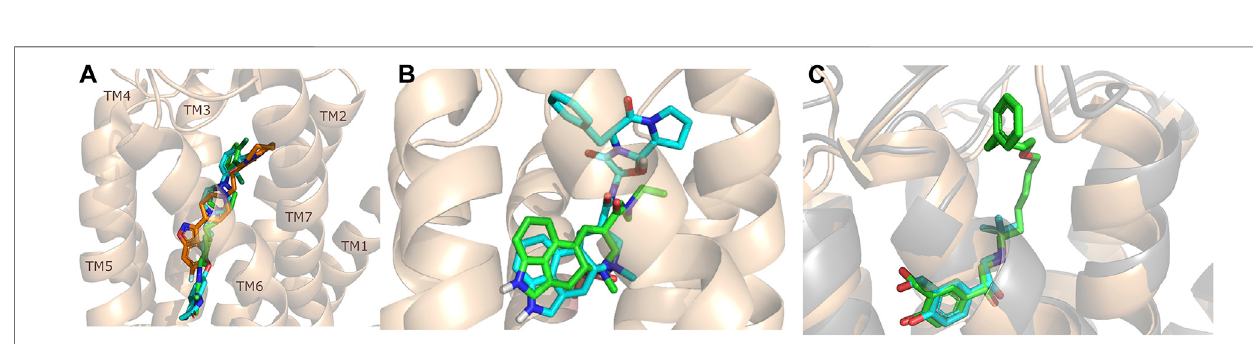
FIGURE 3 | Structures of some important bitopic compounds. (A) The unusual “ upside-down ” binding mode of cariprazine (green) and aripiprazole (cyan) in the inactive 5-HT 2A structure. Risperidone (orange) is shown as a reference to highlight the cryptic pocket opened up by aripiprazole and cariprazine. (B) The aligned LSD (Wacker et al., 2017) and ergotamine (Wacker et al., 2013) 5-HT 2B structure highlighting that the introduction of an SP can in fl uence the binding mode of the PP. The fi gure was reproduced from Supplementary Figure S7 of our paper (Egyed, A et al. Controlling Receptor Function from the Extracellular Vestibule of G-Protein Coupled Receptors. Chem. Commun. 2020, 56 (91), 14167 – 14170) (Egyed et al., 2020). (C) The binding mode of salbutamol (cyan) and salmeterol (green) (Masureel et al., 2018) in the β 2 R highlighting the important role of ECL2 as discussed in more detail in the binding kinetic section of this review.